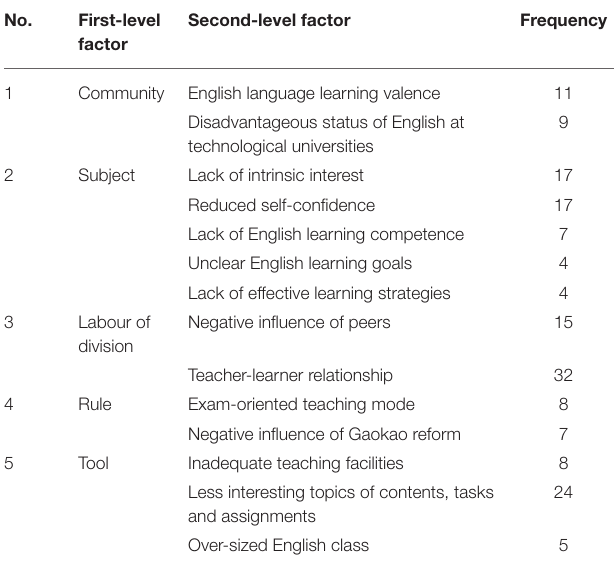
TABLE 2 | Socio-cultural factors identified in the